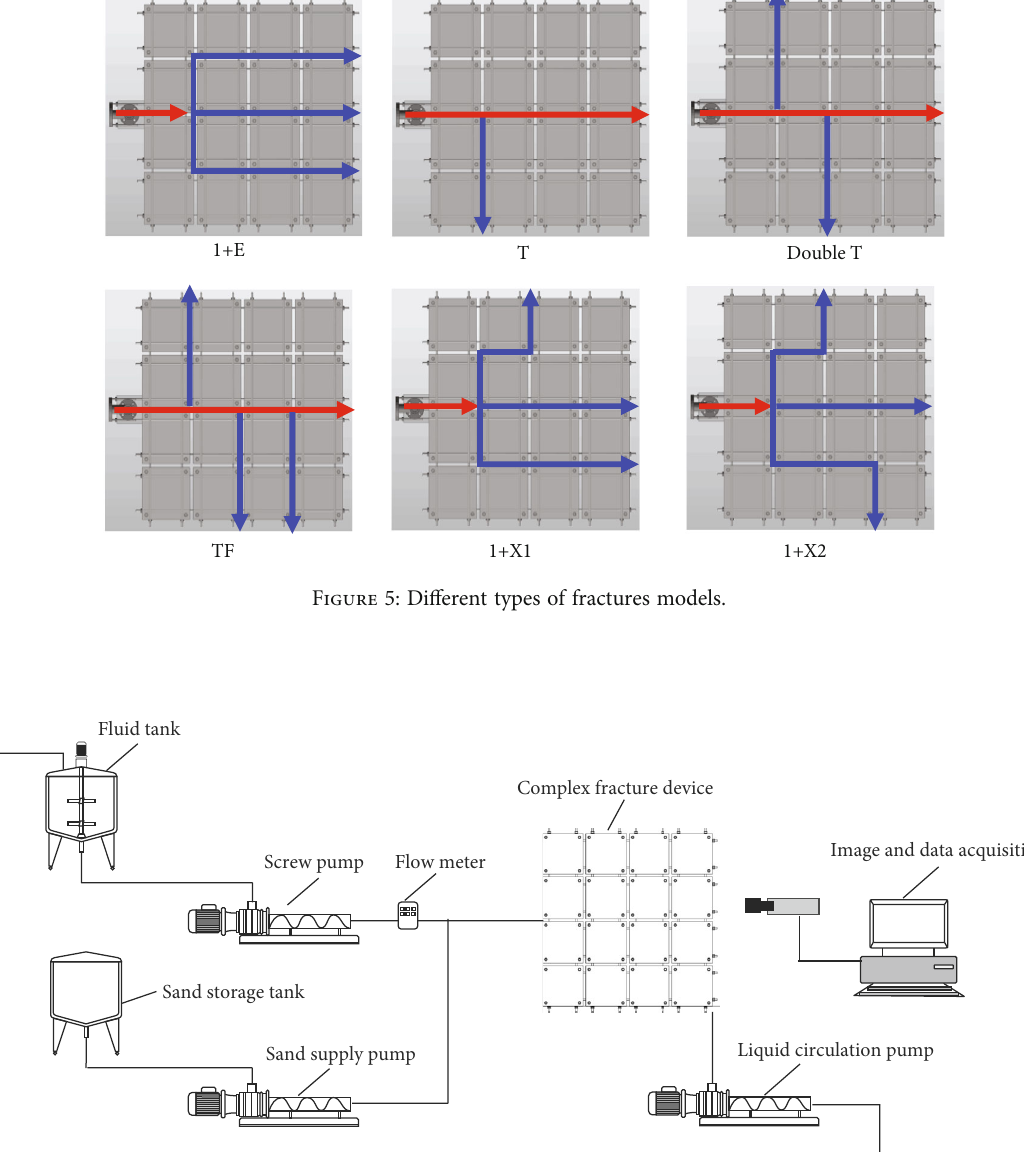
Figure 6: The fl ow chart of the experimental device of proppant transport characteristics in complex